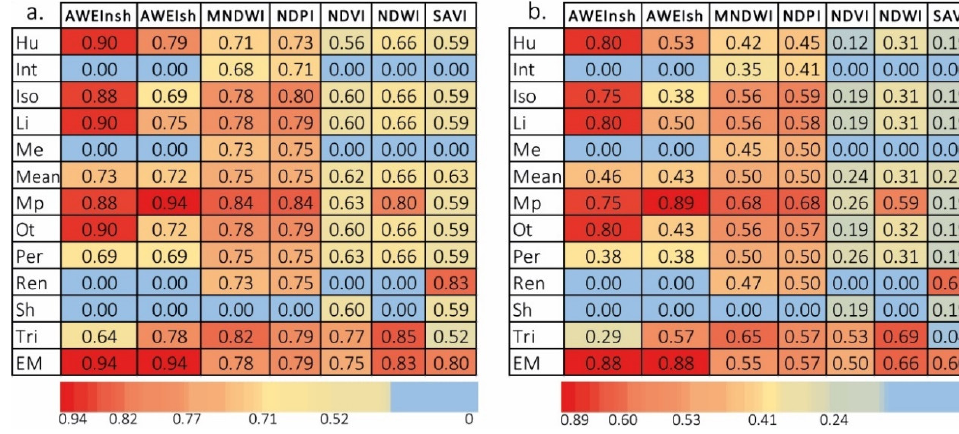
Figure 8. Accuracy values obtained for each index and mapping method: ( a ) Overall accuracy. ( b ) Kappa coefficient. Table 5. Thresholding values obtained from each method.